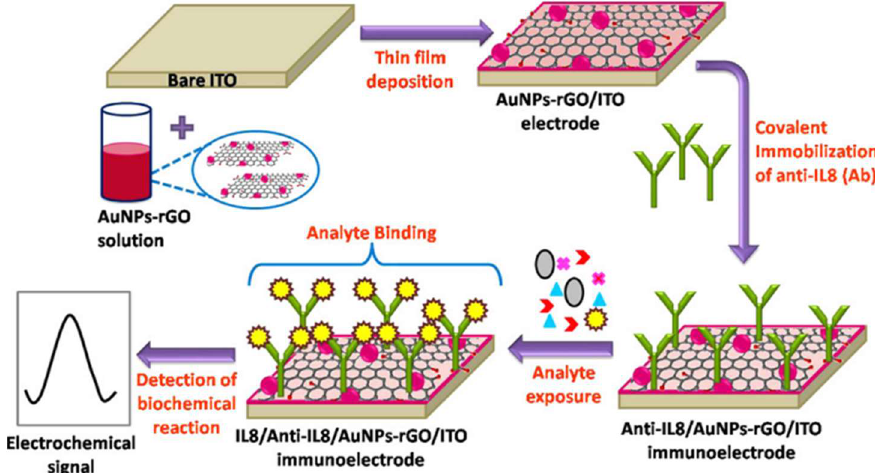
Figure 4. Schematic of fabrication of Au NPs-rGO-based immunoelectrode for immunosensing application. Reproduced from [59], with permission from American Chemical Society, 2017.